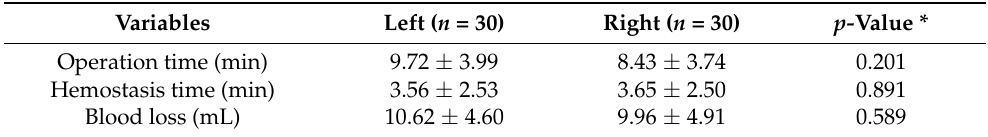
Table 4. Intergroup correlation of operation time, hemostasis time and blood loss by side in the hydrogen peroxide group. Variables Left ( n = 30) Right ( n = 30) p- Value * Operation time (min)